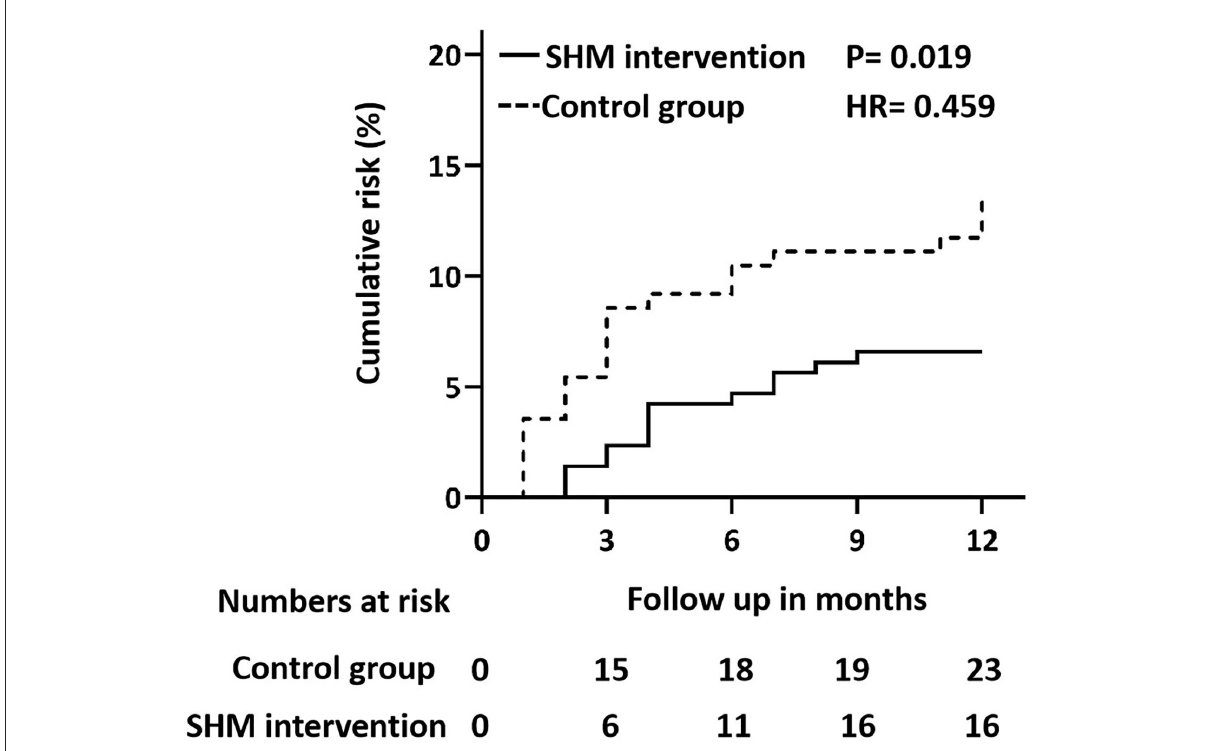
FIGURE2 Cox regression model (proportional hazards model) plot for recurrent ischemic stroke in the control group and SHM intervention group. SHM, stroke health